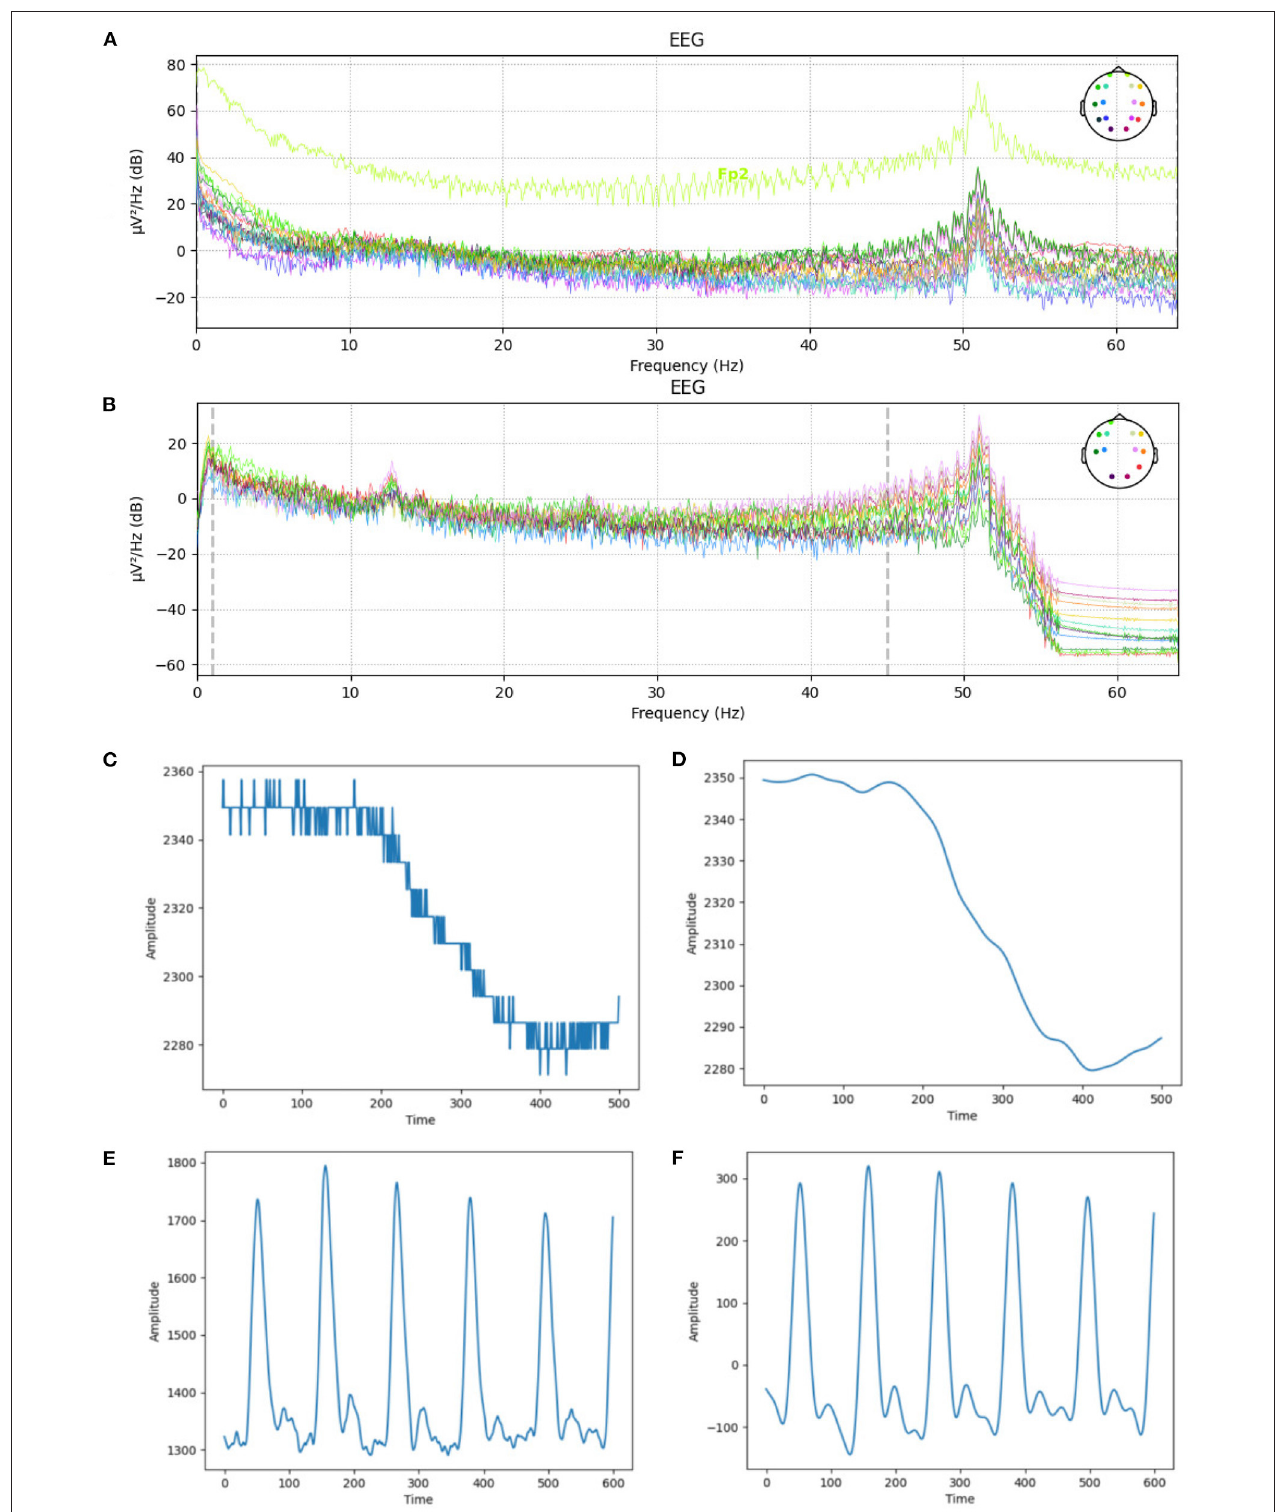
FIGURE 7 | The EEG, GSR, and PPG signals before and after applying preprocessing steps and noise removal. (A) EEG channels’ frequencies before preprocessing. (B) EEG channels’ frequencies after preprocessing. (C) GSR signal’s amplitude before preprocessing. (D) GSR signal’s amplitude after preprocessing. (E) PPG signal’s amplitude before preprocessing. (F) PPG signal’s amplitude after